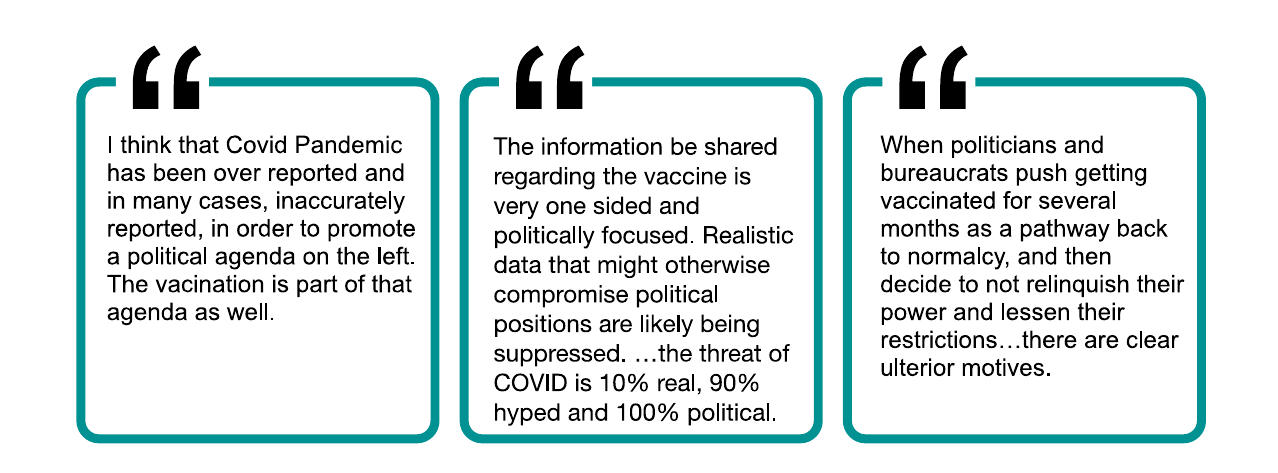
Figure 2. Participant perspectives regarding mistrust in government.